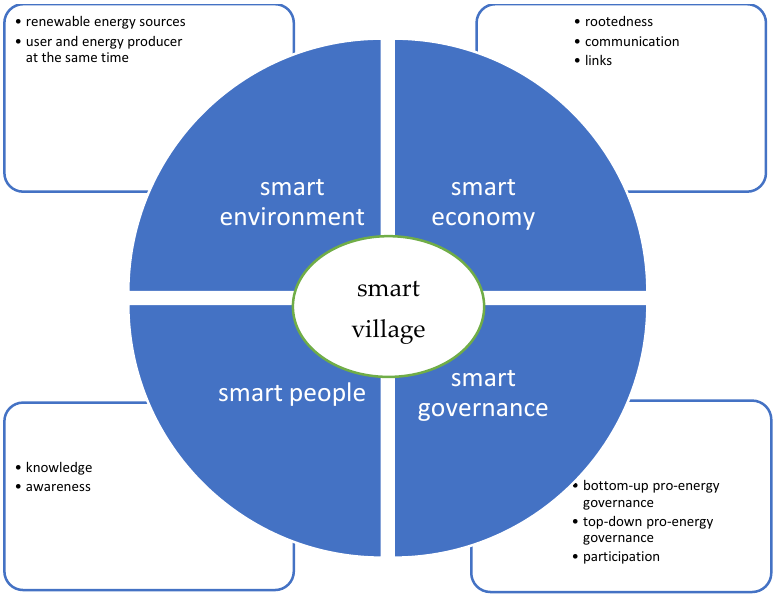
Figure 5. Smart village model. Source: own elaboration.